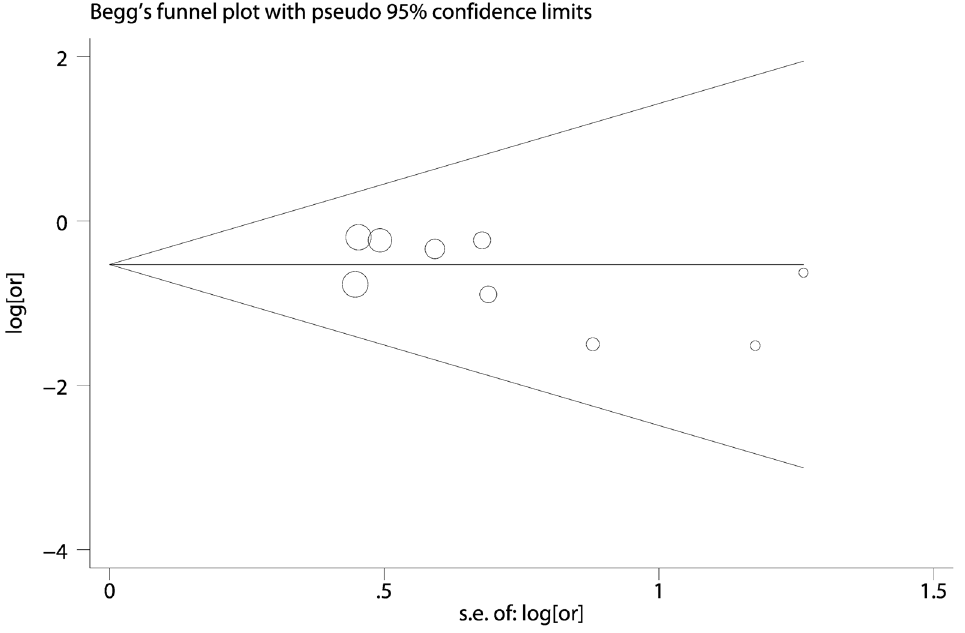
Figure 5. Funnel plot of homozygote comparison (CC vs. GG) estimated by adjusted odds ratios. The circles represent the weight of individual study. Egger’s test p=0.124; Begg’s test,